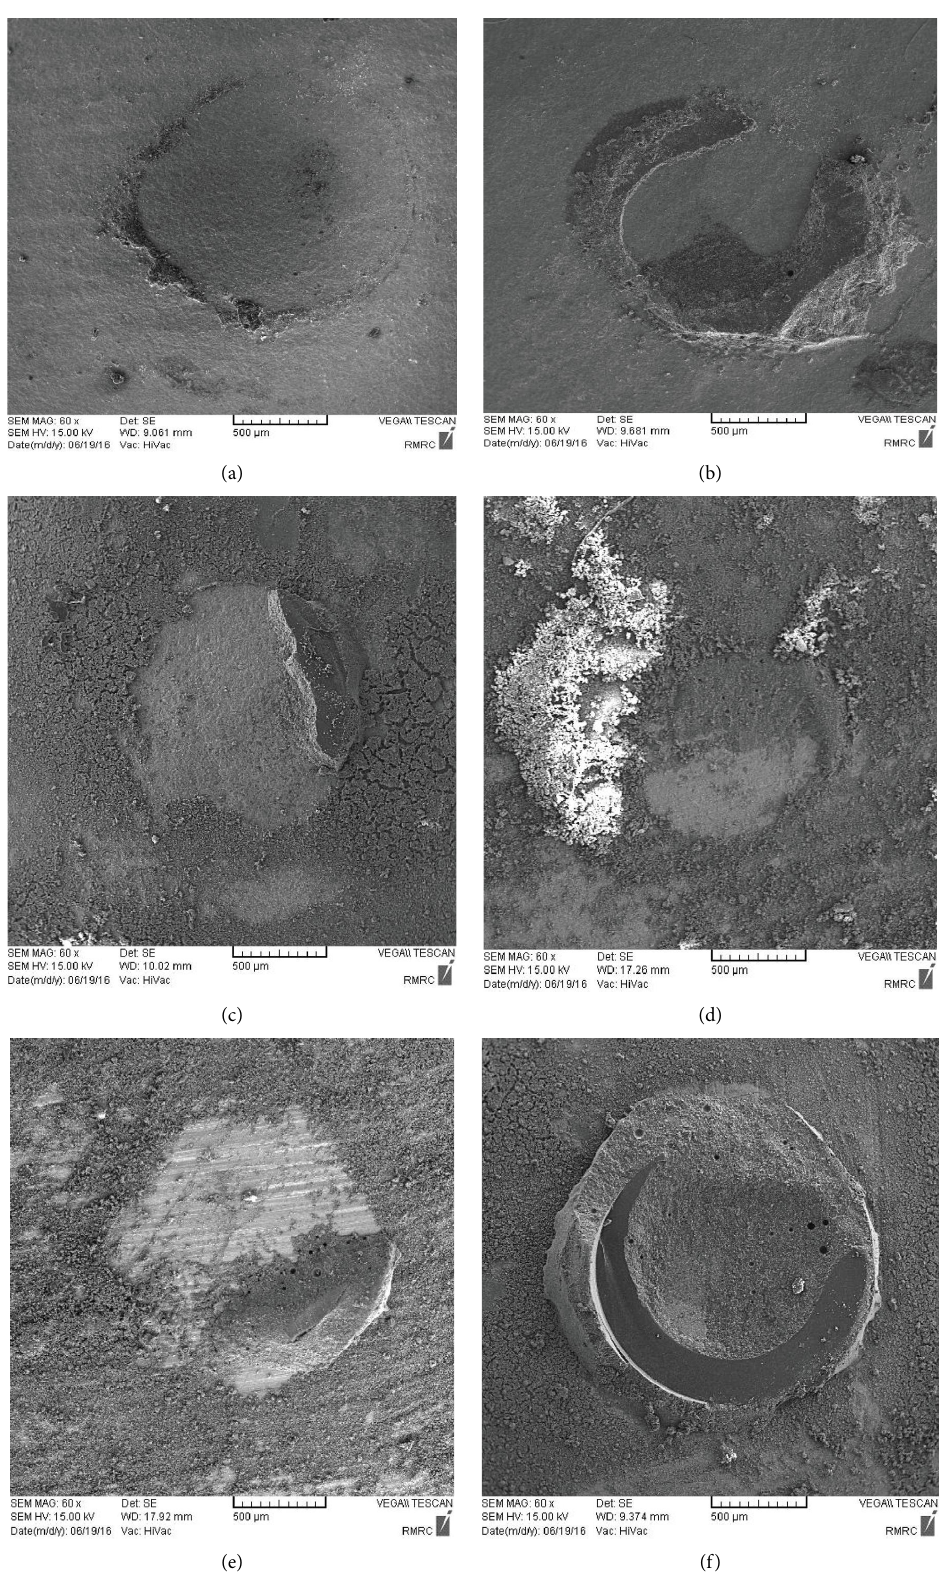
Figure 2: Al 2 O 3 particle abraded group (group 1). (a) Adhesive failure mode. (b) Mixed failure mode. (c) Sandblast +HA coating group (group 3). (d) HA coated group (group 2) Er, Cr: YSGG +HA-coating group (group 4). (e) Mixed failure mode. (f) Cohesive failure